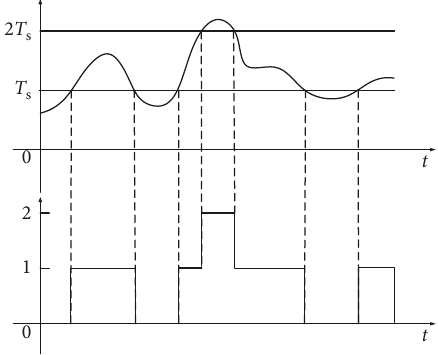
Figure 2: Discretization process of time